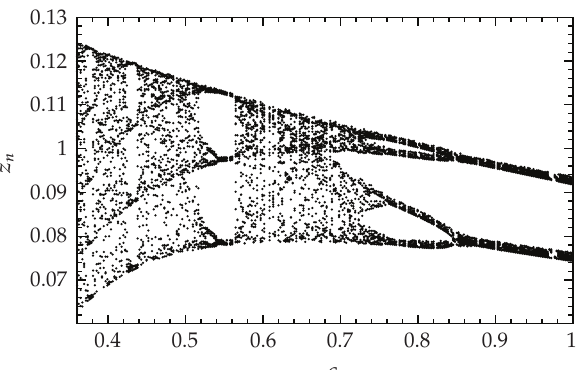
Figure 4: Bifurcation diagram for z n as a function of ε , with δ 2 (cid:7) 0 . 662 and (cid:3) ∈ (cid:5) 0 . 36 , 1 . 0 (cid:5) .